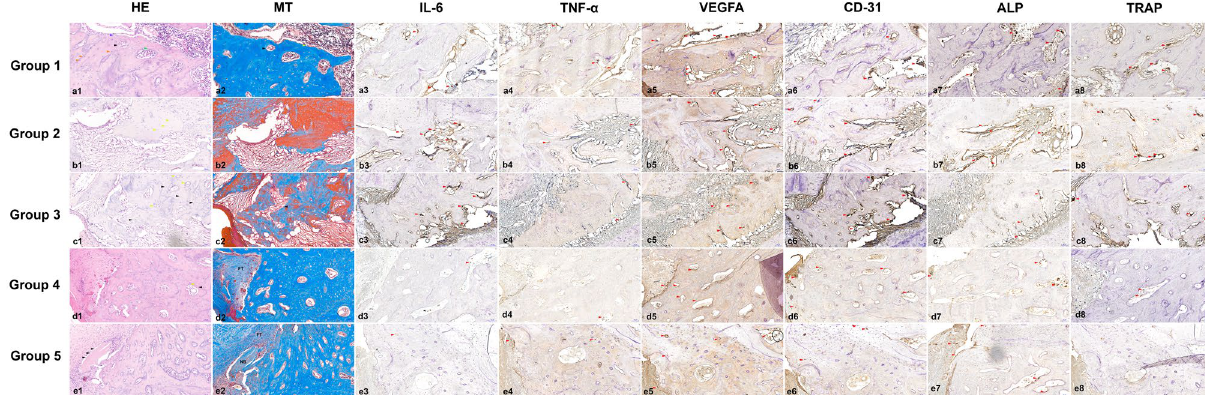
Figure 6. Representative histological and immunohistochemistry images from the PO BRONJ model at ×20 magnification, 50 μm. The H&E-stained slide from group 1 shows healthy osteocytes (orange arrowheads), osteoblast lining (blue arrowhead), Haversian canal (black arrowhead), and the incremental line of the bone (green arrowhead) ( a1 ). In the MT staining, newly formed bone composed of abundant healthy osteocytes with a Haversian canal (black arrowhead) and osteoblast lining (yellow arrowhead) are visible ( a2 ). Several pyknotic osteocytes (yellow arrowheads) appear in the H&E-stained slide from group 2 ( b1 ). Connective tissues are visible ( b2 ). Several empty lacunae (black arrowheads) and empty Haversian canals (yellow arrowheads) are visible in the H&E-stained slide from group 3 ( c1 ). Thinning of the osteoblast lining (black arrowhead) is visible in the MT-stained slide from group 3 ( c2 ). In group 4, the bone is filled with a mix of healthy osteocytes, pyknotic osteocytes, and empty lacunae. An area of bone resorption (black arrowhead) indicating osteon reconstruction is characterized by the osteoblast lining at the periphery (yellow arrowhead) and loose connective tissue in the center ( d1 ). Fibrous tissue in the extraction socket is visible ( d2 ). In group 5, bone composed of a mix of healthy osteocytes, pyknotic osteocytes, and empty lacunae can be seen. Below the fibrous tissue, an area of nonvital bone composed of empty lacunae (black arrowheads) is visible ( e1 ). Bone composed of a mix of healthy osteocytes, pyknotic osteocytes, and empty lacunae can be seen. Below the fibrous tissue, an area of nonvital bone composed of empty lacunae is visible ( e2 ). In immunohistochemistry images, red arrows indicate antibody expression. In terms of inflammation-related markers, the acute phase was shown with 3 weeks of administration, and the long-term effects of alendronate, low expression of IL-6, were shown upon 8 weeks of administration. VEGFA expression was suppressed by alendronate in the experimental groups. The attached-osteoclast ratio expressed by TRAP decreased over time. CD31 and ALP were moderately expressed in all groups. FT fibrous tissue, NB nonvital